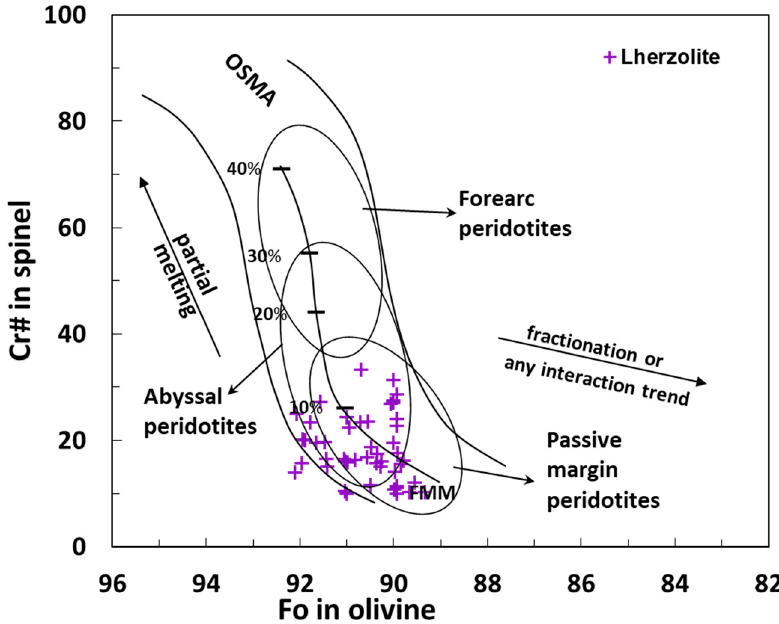
Figure 8. Plot of spinel Cr# against olivine Fo from the lherzolite of the Edessa ophiolite. Fields for abyssal peridotites [41,64], the forearc peridotites and passive continental margin peridotites [60] are also shown for comparison. The olivine-spinel mantle array (OSMA), partial melting trend and fractional lines are from Arai [41,64].